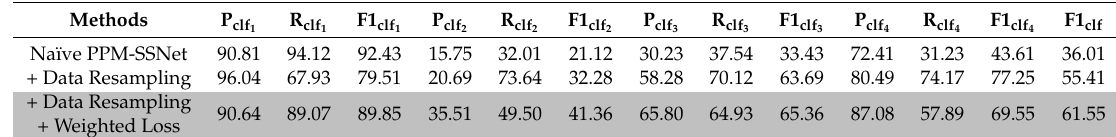
Table 3. Ablation study of category imbalance technique